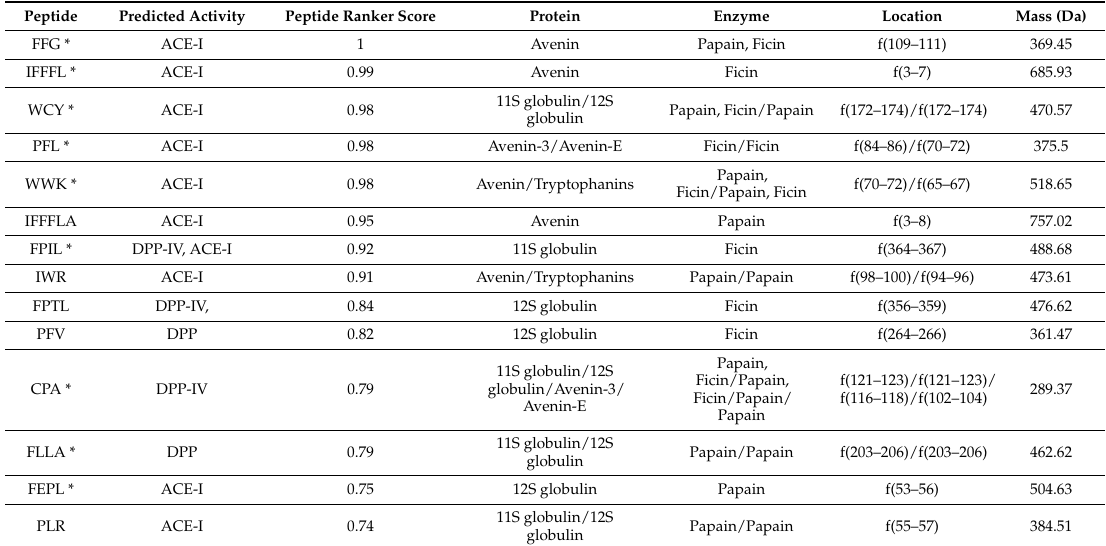
Table A1. Top 15 novel peptide hydrolysates identified following in silico hydrolysis of oat proteins with proteases papain and ficin that were predicted to have high bioactivity for the inhibition of ACE-I and